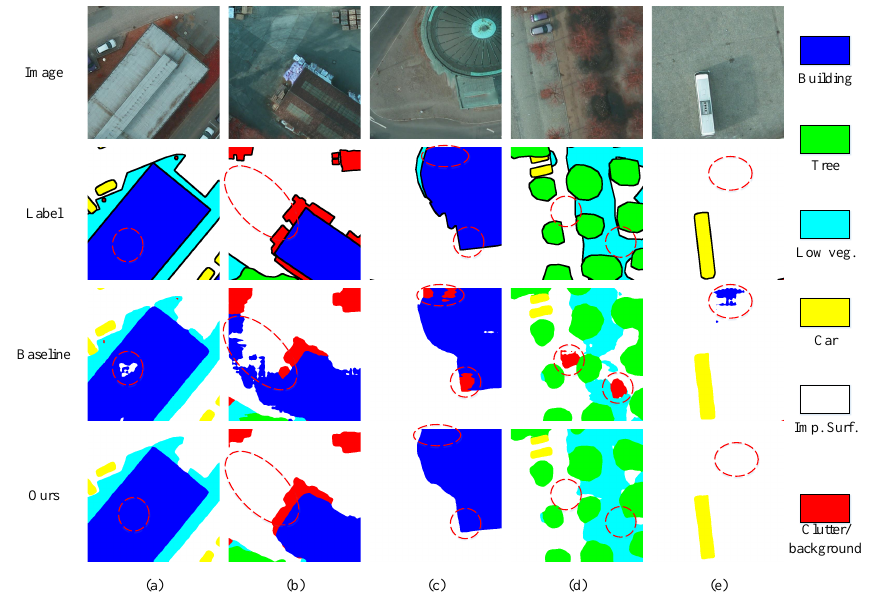
Figure 7. Visualization of the prediction results of different methods on the Potsdam dataset. ( a – e ) correspond to five different input images, labels and segmentation